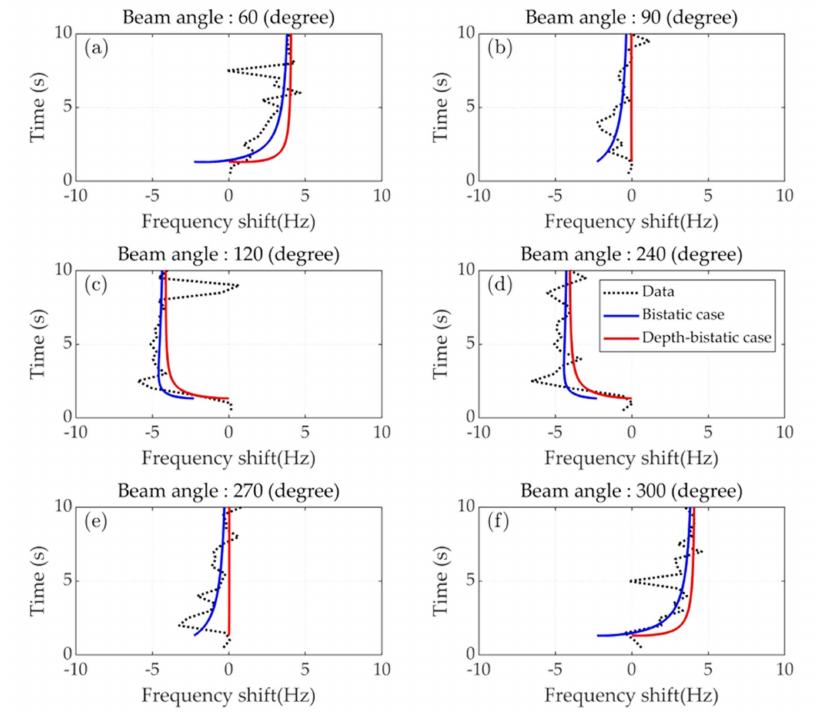
Figure 14. Comparison of the modeled Doppler shift and the extracted Doppler shift from data for six relative beam directions at ping 120. The black dotted line indicates the extracted result. The blue solid line and the red solid line indicate the modeled result of a bistatic geometry and of a depth-bistatic geometry. ( a ) 60 ◦ , ( b ) 90 ◦ , ( c ) 120 ◦ , ( d ) 240 ◦ , ( e ) 270 ◦ , and ( f ) 300 ◦